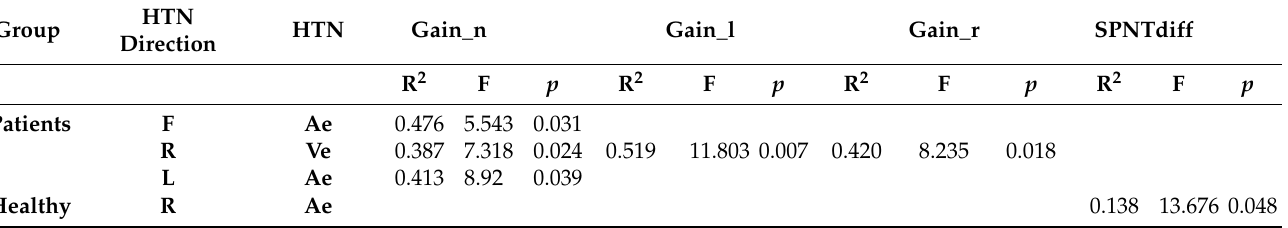
Table 5. Relations between eye movements during smooth pursuit neck torsion test and the head-to- neutral relocation